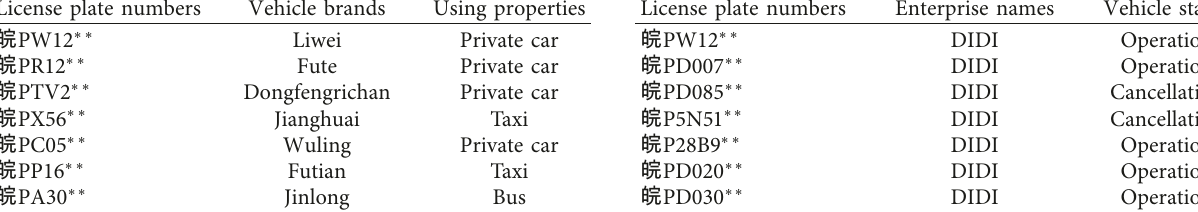
Vehicle brands Using